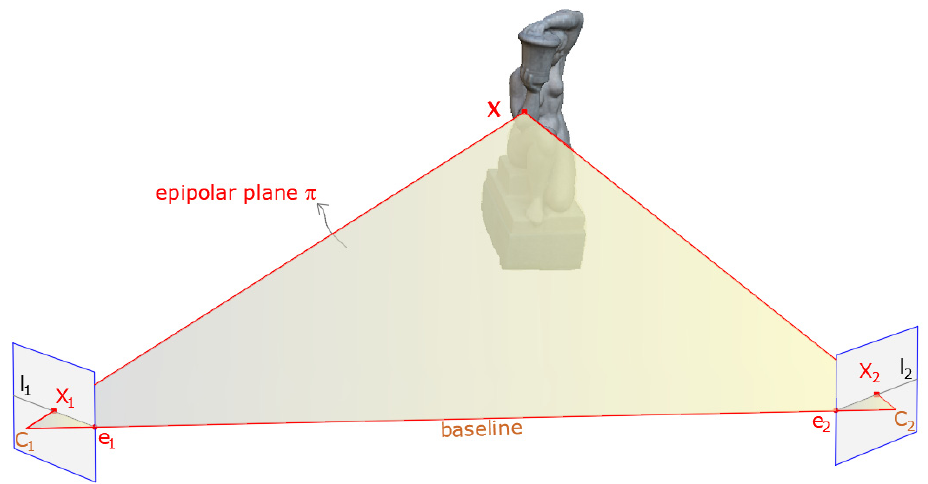
Figure 9. Fundamentals of epipolar geometry.